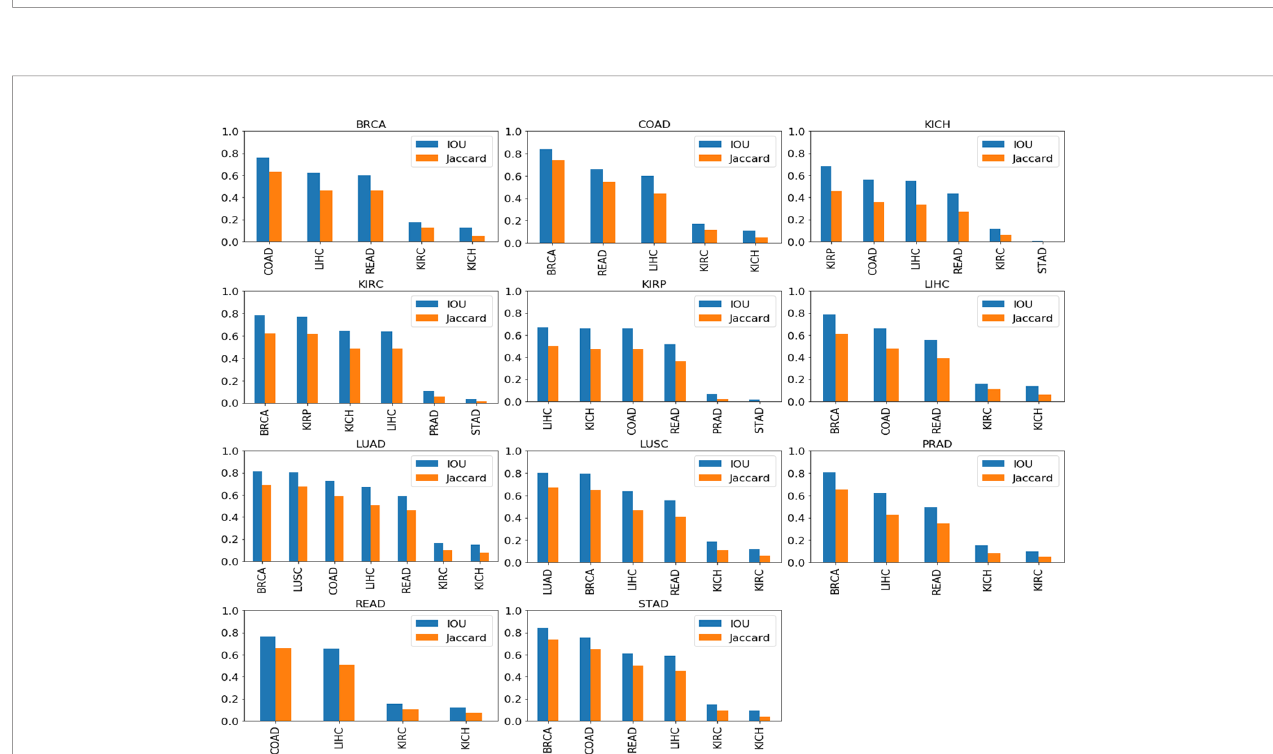
FIGURE 7 | Cross-organ GradCAM results showing the IoU and Jaccard index of high-attention regions. The model used for visualization is indicated on the title of each plot, and the subtypes used are indicated on the x-axis.